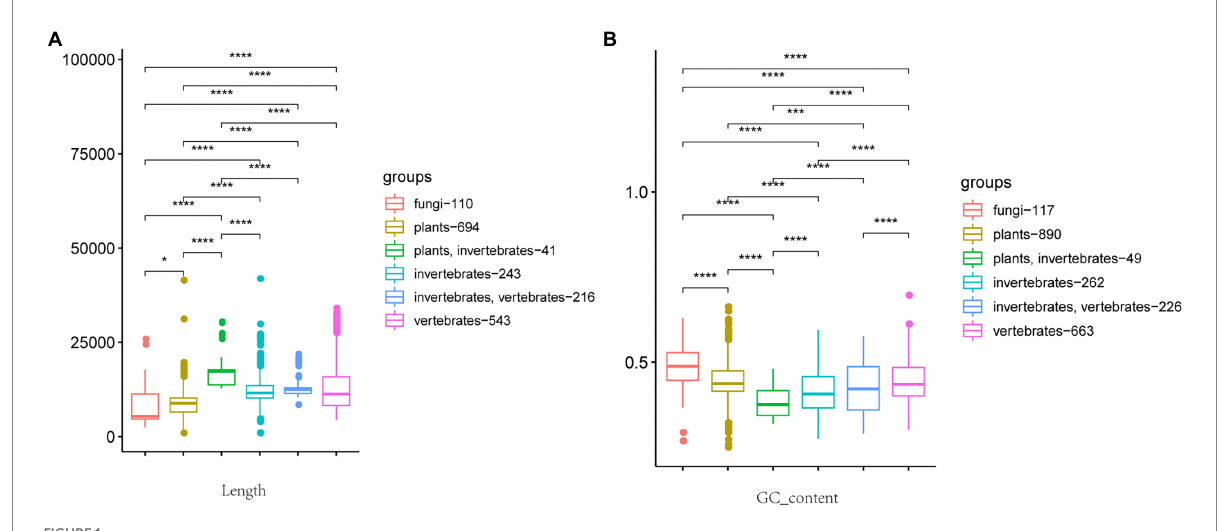
FIGURE 1 Box plot of relationship between viral genome length, GC content, and host. (A) Relationship between viral genome length and host. (B) Relationship between GC content and host. The host from left to right is fungi, plants, plants + invertebrates, invertebrates, invertebrates + vertebrates, and vertebrates. The number after the host represents the number of viruses included in the statistics. (Wilcoxon rank- sum test, * p ≤ 0.1, **** p ≤ 0.0001.)